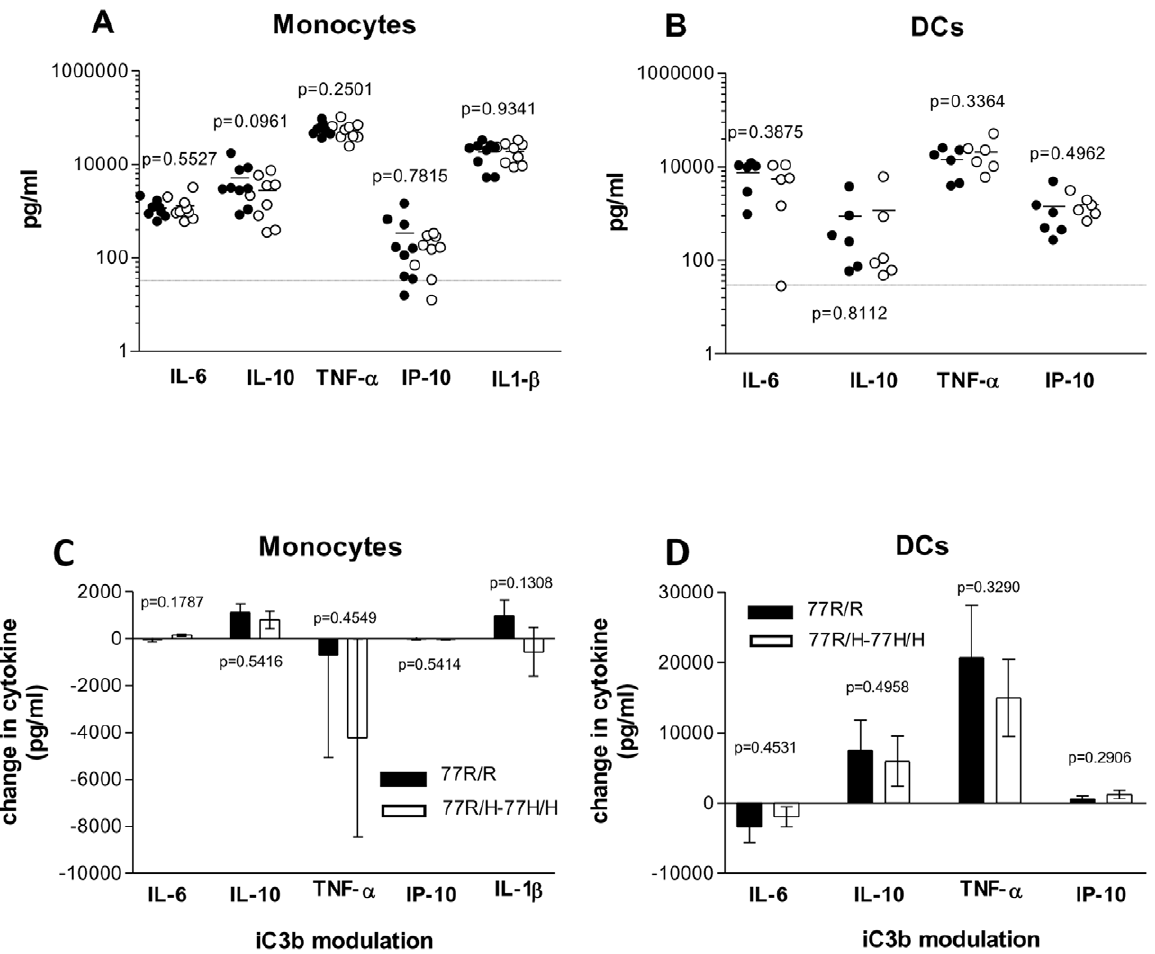
Figure 5. Cytokine response. Monocytes (A), DCs (B) were stimulated with 2 m g/ml and 10 m g/ml of TLR7/8 ligand (R848) respectively for 24 h. Cytokines quantified using a bead multiplex assay. Closed symbols: 77R/R cells, open symbols: 77R/H-77H/H cells. Each dot represents a single individual, bars denote means. No significant differences between the two CD11b genotypes. Statistical analysis by paired t test. (C, D) Modulation of TLR7/8-induced cytokine release by hiC3b-coated beads. Monocytes (C), DCs (D) were fed with hiC3b-coated beads one hour prior to R848 stimulation. The cytokine changes between the samples with and without CR3 pre-engagement with iC3b are shown with the p values indicated. Data are expressed as mean + / 2 SEM. The cytokine responses of 77R/R cells (black column) and 77R/H-77H/H cells (white columns) were not statistically different in paired assays. IL, interleukin; TNF- a , tumour necrosis factor alpha; IP-10, Interferon gamma-induced protein 10.